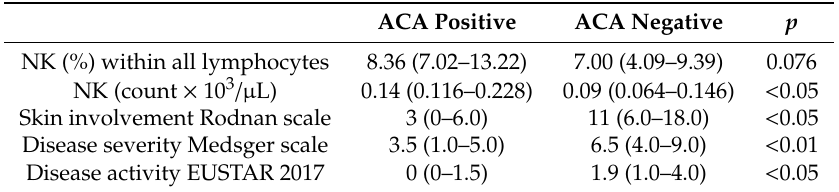
Table 5. Relation between anti-centromere antibody (ACA) positivity and NK cells, disease severity, and activity in patients with systemic sclerosis.